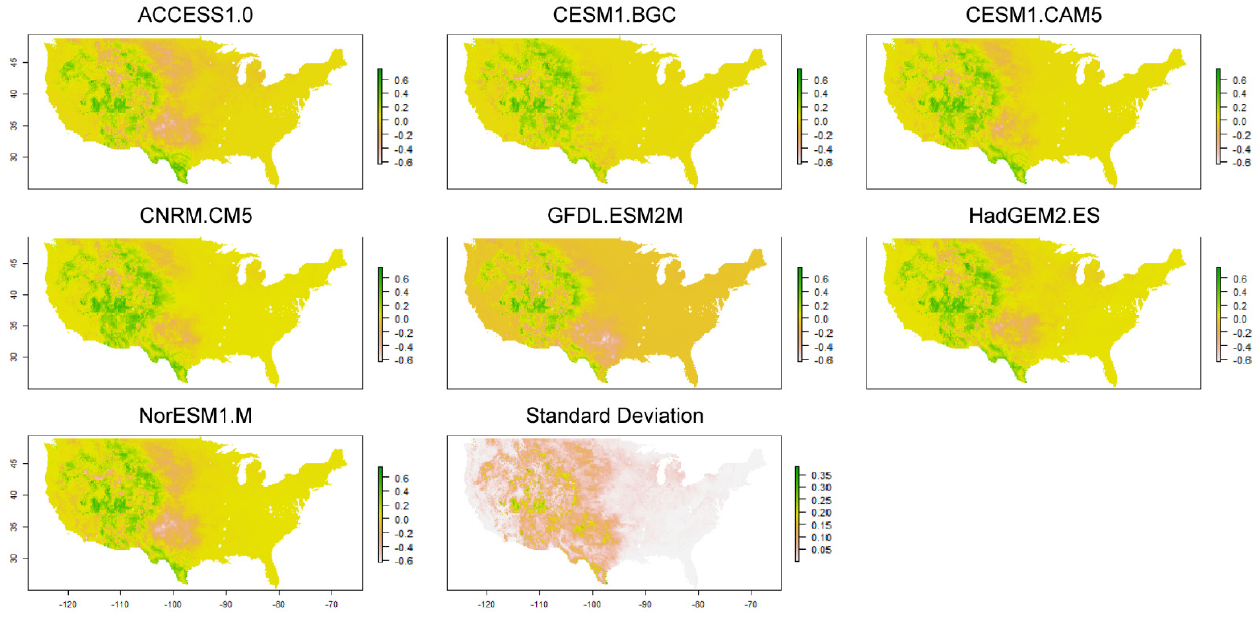
Figure A6. The difference (climate-only model–full model) in relative occurrence rates for the full model and the model parameterized with climate and static factors (climate-only) for each climate projection selected for analysis under RCP 4.5 described in Table A2. The standard deviation of all model outputs is also shown.